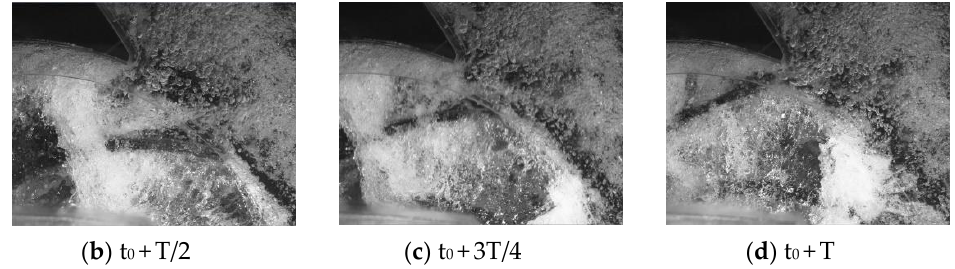
Figure 9. Flow tracing at φ = 0.014 for α = 2% at different timestep.